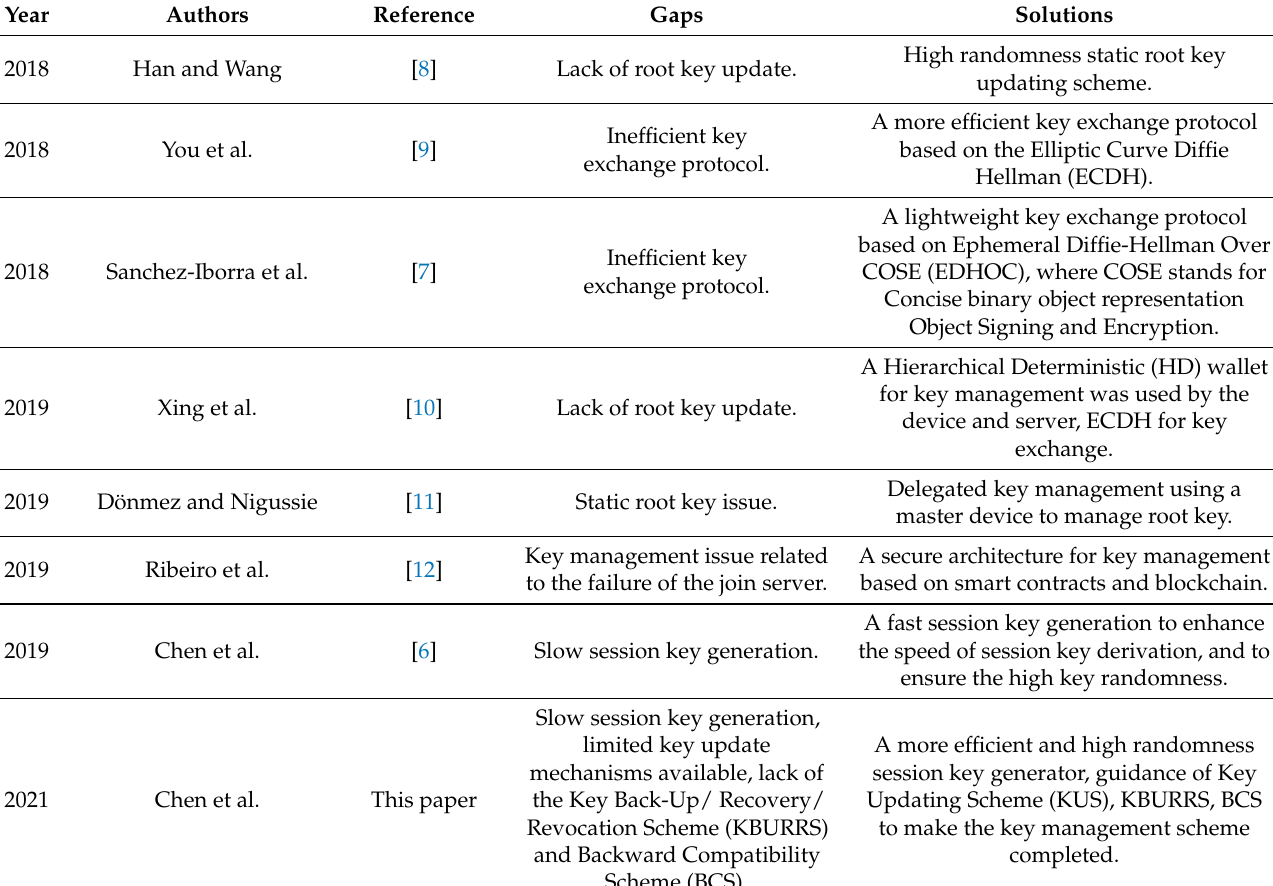
Table 1. Comparison between different key management solutions and our proposed